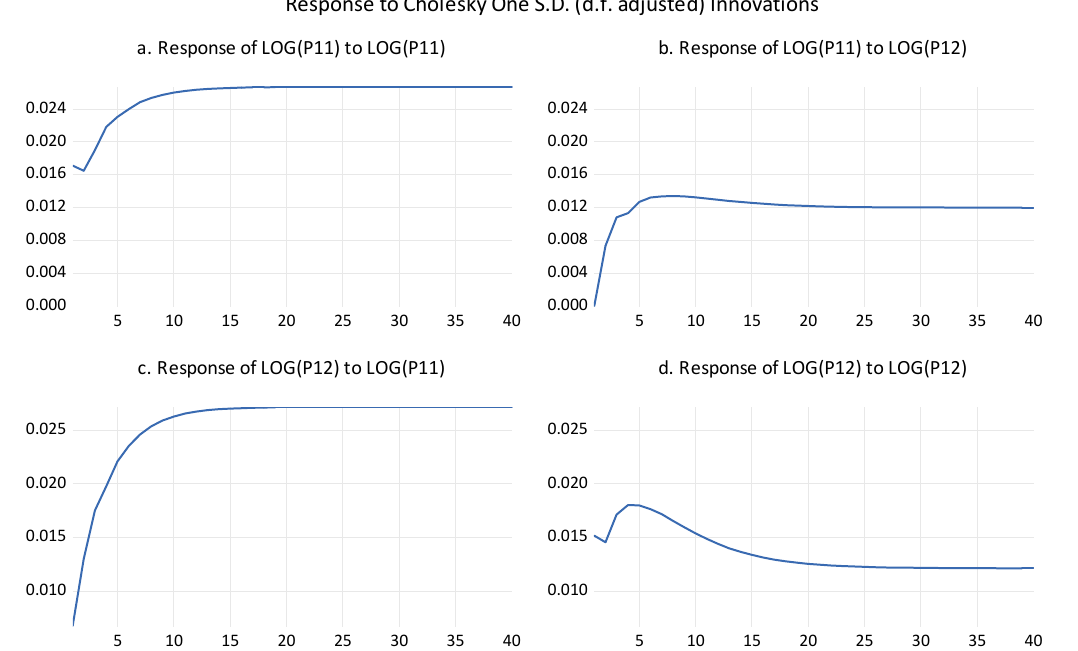
Figure A1. Impulse response estimates for butter in blocks prices in Central and Northern region, Poland, 5 January 2014 to 5 November 2017. ( a ) Response of butter prices in Central region to region’s lagged prices. ( b ) Response of butter prices in Central region to lagged prices in Northern region. ( c ) Response of butter prices in Northern region to lagged prices in Central region. ( d ) Response of butter prices in Northern region to region’s lagged prices